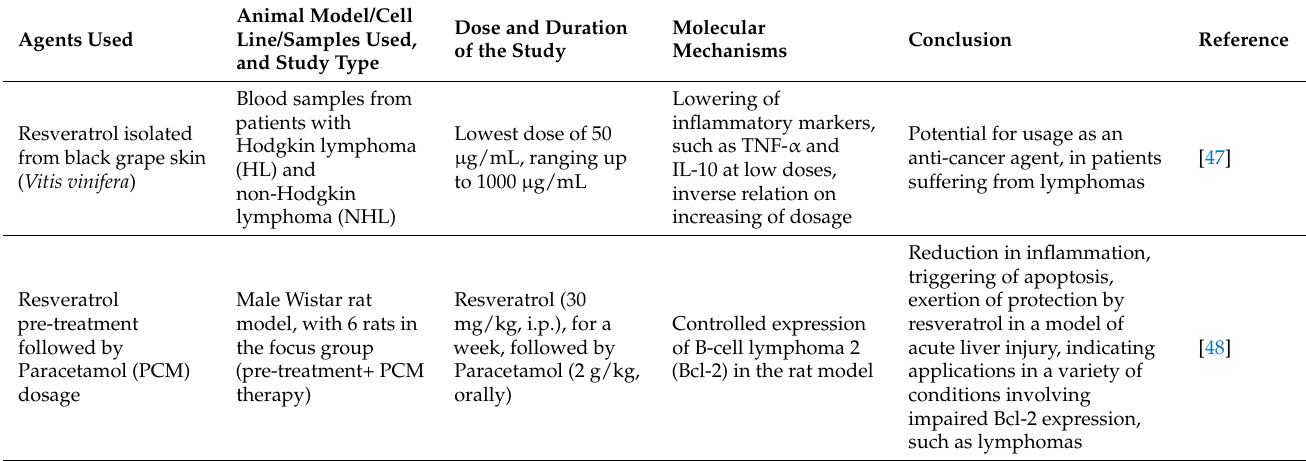
Table 1. Pre-clinical studies of resveratrol in the management of B-cell malignancies.